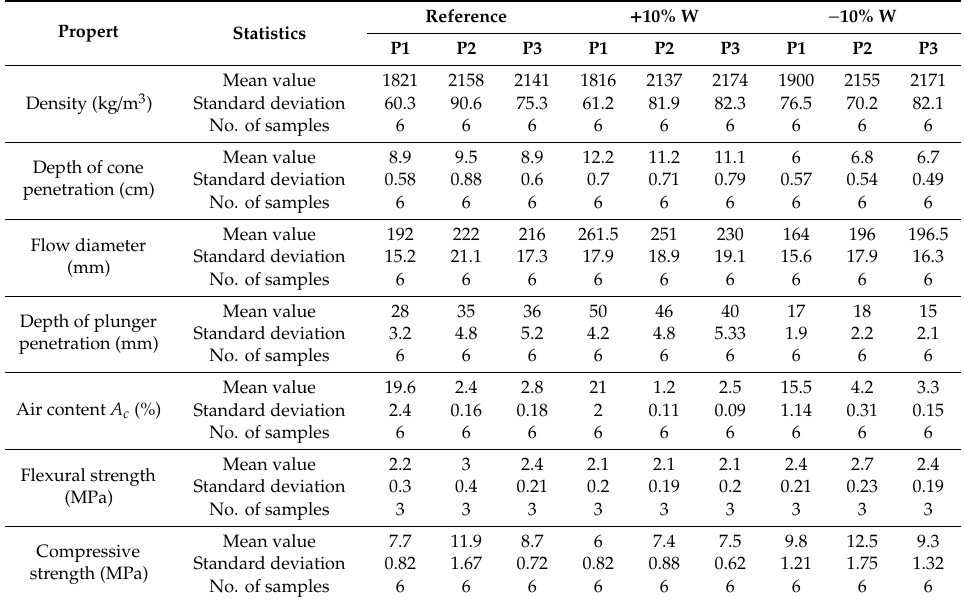
Table 13. Results of tests of the influence of water dosing mistakes on properties of plaster.